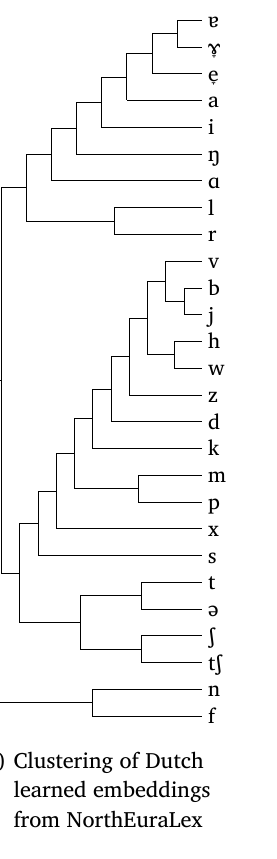
feature matrix from Brown et al. (2008)